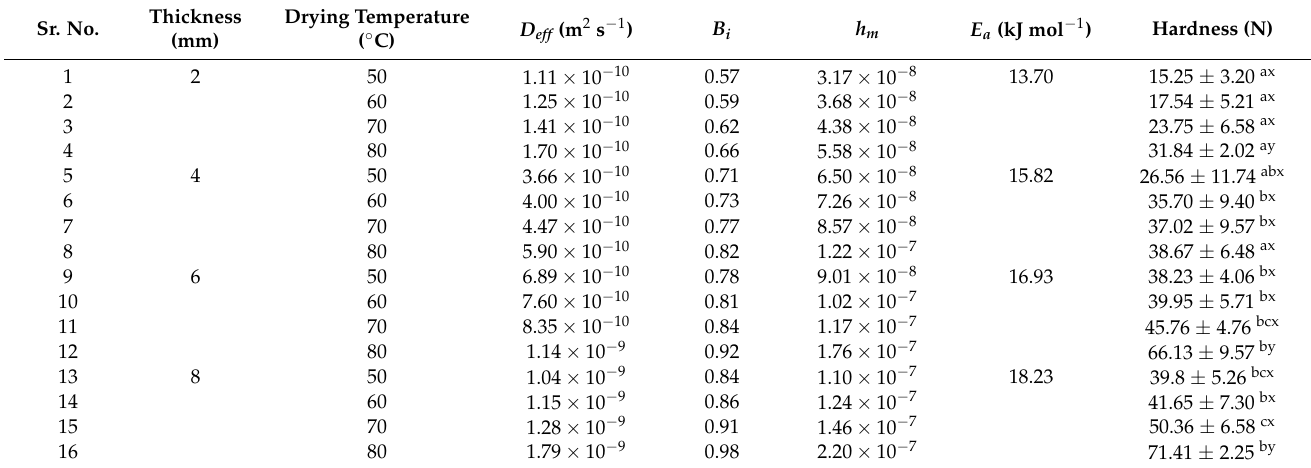
Table 3. Heat transfer parameter, mass transfer parameter, activation energy, and hardness of convectively hot air-dried plantain banana